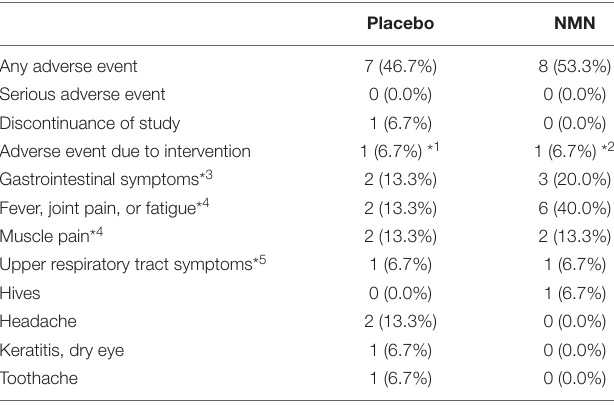
TABLE 2 | Adverse events.